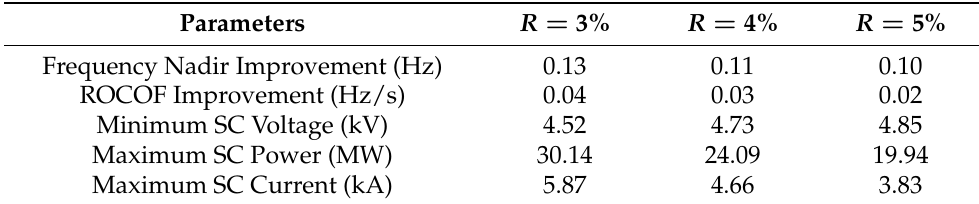
Figure 12. FFR provision from the converter-connected SC with varying droop coefficients (from top to bottom: system frequency, SC terminal DC voltage, SC output DC power, SC output DC current). Table 4. Overview of simulation results of FFR provision from the converter-connected SC in systems with varying droop